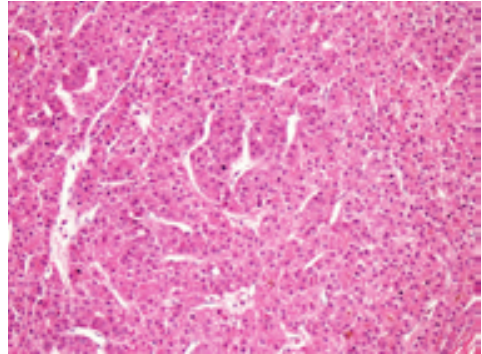
Figure 4 The histopathology’s diagnosis is that the lesion was HCC and it was moderately